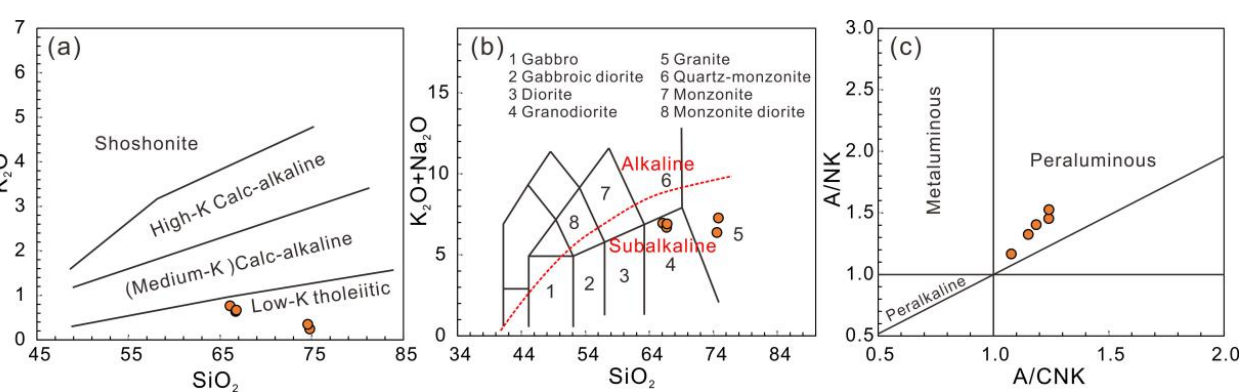
Table 1. Chemical compositions of major elements (wt %) and trace elements (×10 − 6 ) of the Late Permian granitic pebble samples from the Jin ′ gui Island. Sample